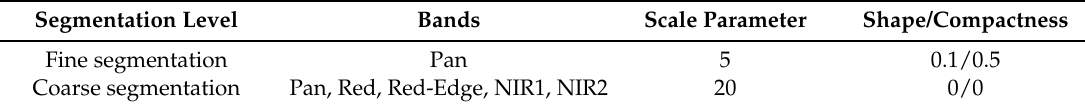
Table 2. Overview of the parameters used to create the two segmentation levels.